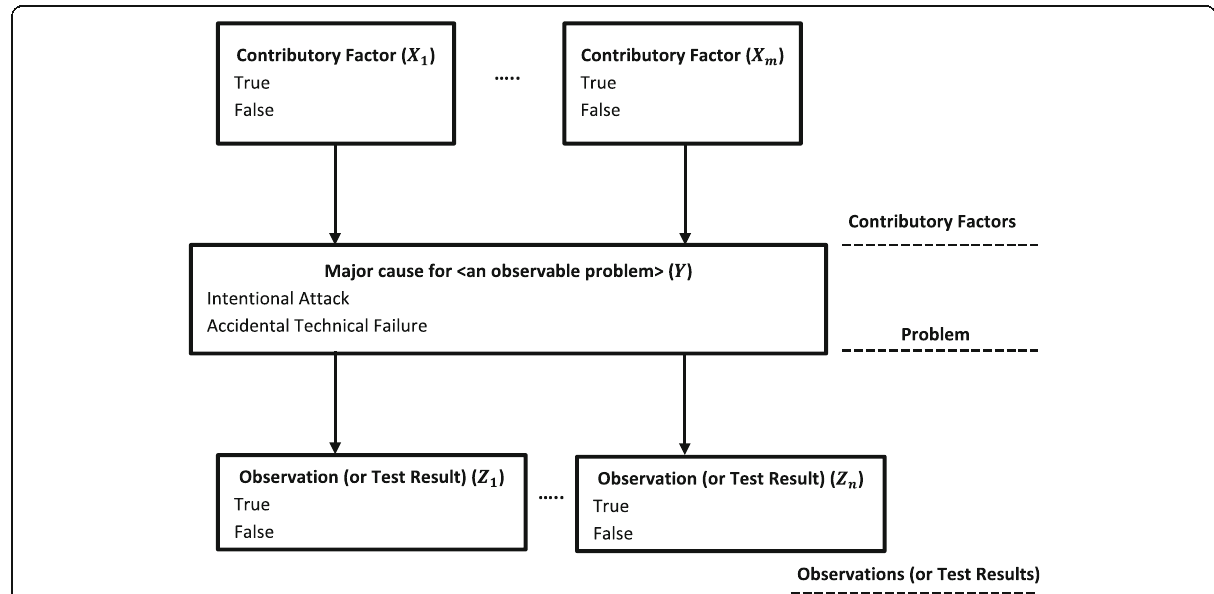
Fig. 2 Framework for Distinguishing Attacks and Technical